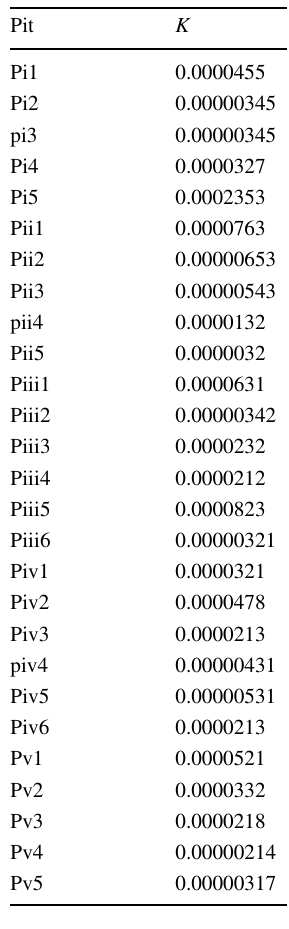
Table 2 Hydraulic conductivity